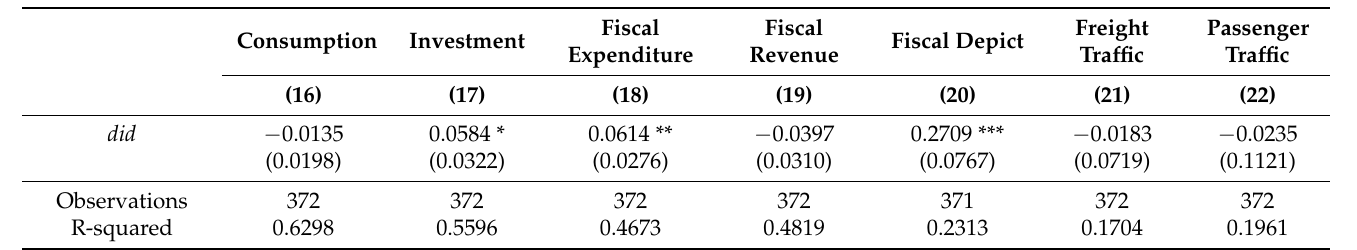
Table 3. Mechanism